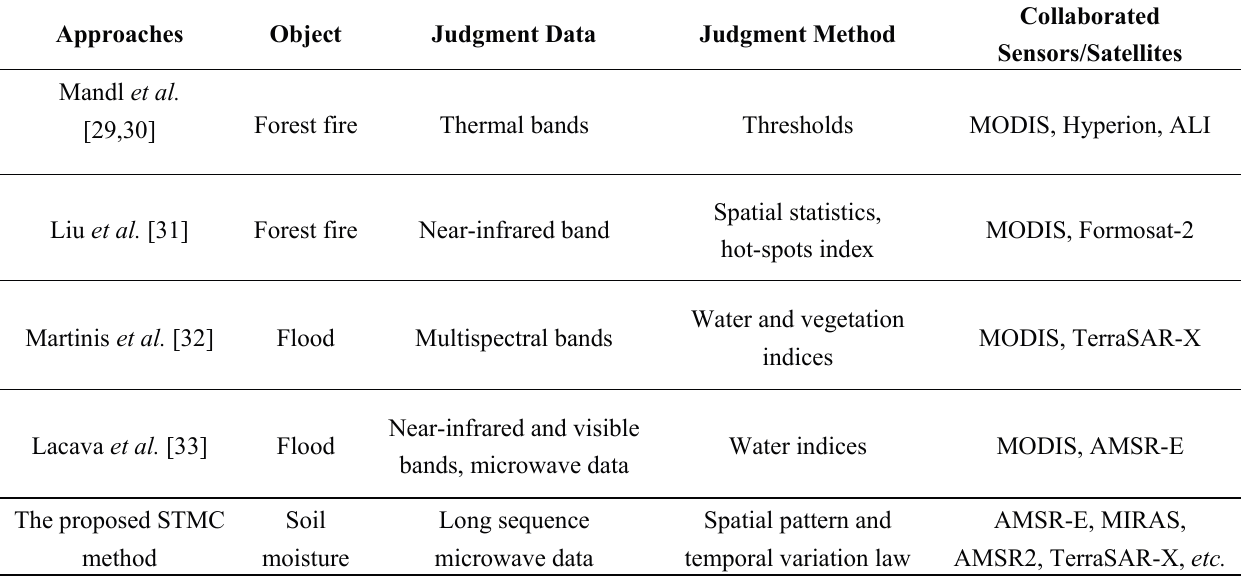
Table 4. Approaches comparison between the proposed STMC and other related methods.